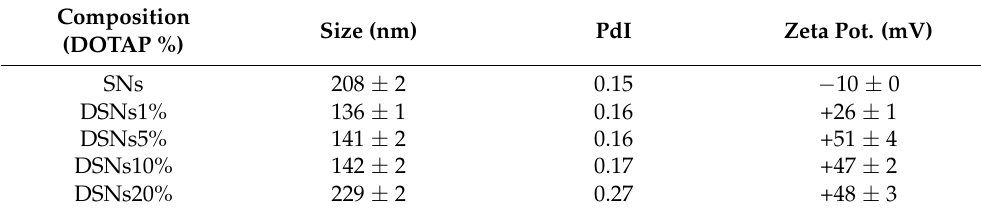
Table 2. Characterization of SNs and DSNs with increasing percentages of DOTAP. Composition (DOTAP